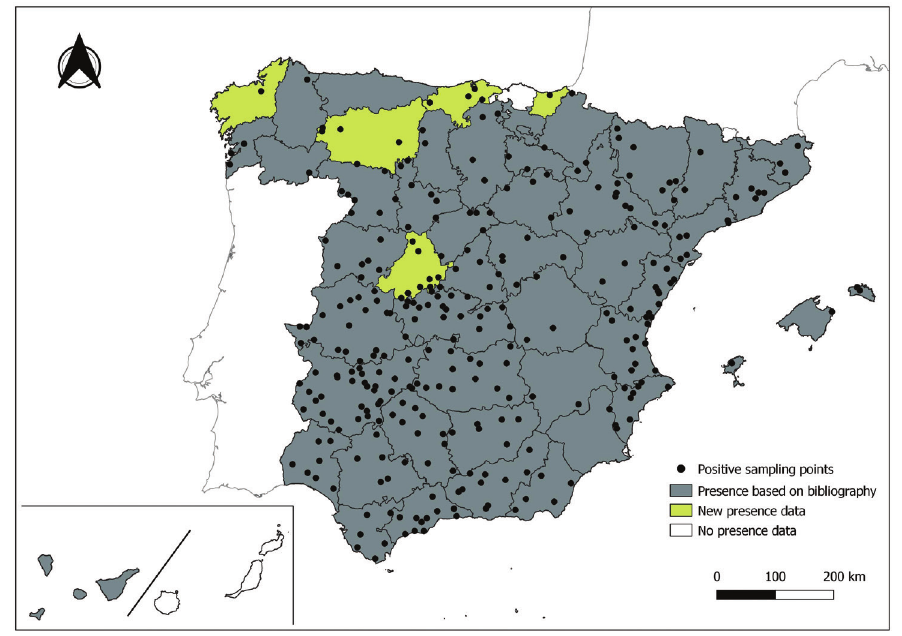
Figure 1. Distribution of Phlebotomus perniciosus in